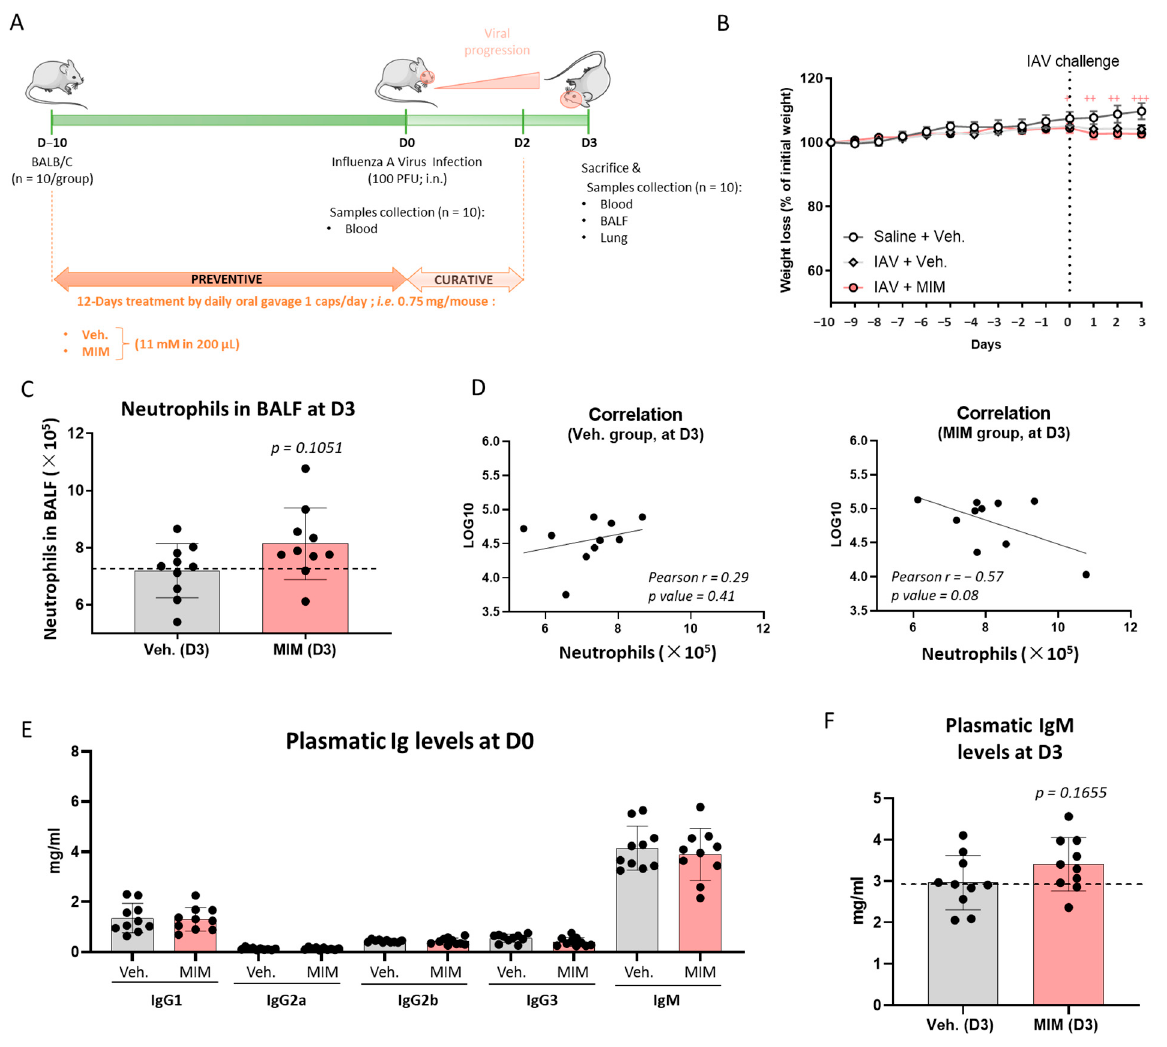
Figure 3. MIM can help the recruitment of neutrophils to the lungs and increases the plasmatic levels of IgM in an in vivo model of respiratory infection induced by influenza A virus (IAV). ( A ) Representative scheme of the general experimental protocol. MIM or vehicle (Veh.) at 11 mM was administrated daily by oral gavage from Day–10 (D–10) to Day 2 (D2) to BALB/cJRj female mice (n = 10 mice per group). The animals were intranasally (i.n.) infected with IAV (100 PFU) on D0, one hour after MIM or Veh. administration. Mice were euthanized on Day 3 (D3) and blood, bronchoalveolar fluid (BALF) and lungs were collected. ( B ) Effect of MIM treatment on body weight changes has been investigated. Data are mean ± SEM of 10 mice per group. Statistical evaluation of differences between the experimental groups was determined by using two-way ANOVA followed by a Dun- nett’s multiple comparisons post-test. p values of less than 0.05 were considered significant. + p < 0.0332, ++ p < 0.0021, +++ p < 0.0002. The statistical analysis was performed with GraphPad Prism, Version 9 for Windows (GraphPad Software Inc., San Diego, CA, USA, www.graphpad.com ac- cessed on the 29 th of July 2021). ( C ) Neutrophil recruitment in BALF on D3. Neutrophil counts in BALF were analyzed and the represented data are the mean ± SD of 10 mice per group. Nonpara- metric Mann–Whitney test was performed ( p = 0.1051) to compare both groups. ( D ) Correlations between the viral load in the lungs and the number of neutrophils in the BALF on D3 in the groups treated with vehicle (left panel) and MIM (right panel). Pearson’s r scores and p values are depicted in each graph. ( E ) Plasmatic immunoglobulin levels of IgG1, IgG2a, IgG2b, IgG3 and IgM on D0. ( F ) Plasmatic immunoglobulin levels of IgM on D3 post-IAV. IgM was analyzed and the represented data are the mean ± SD of 10 mice per group. Nonparametric Mann–Whitney test was performed ( p = 0.1655) to compare both groups.